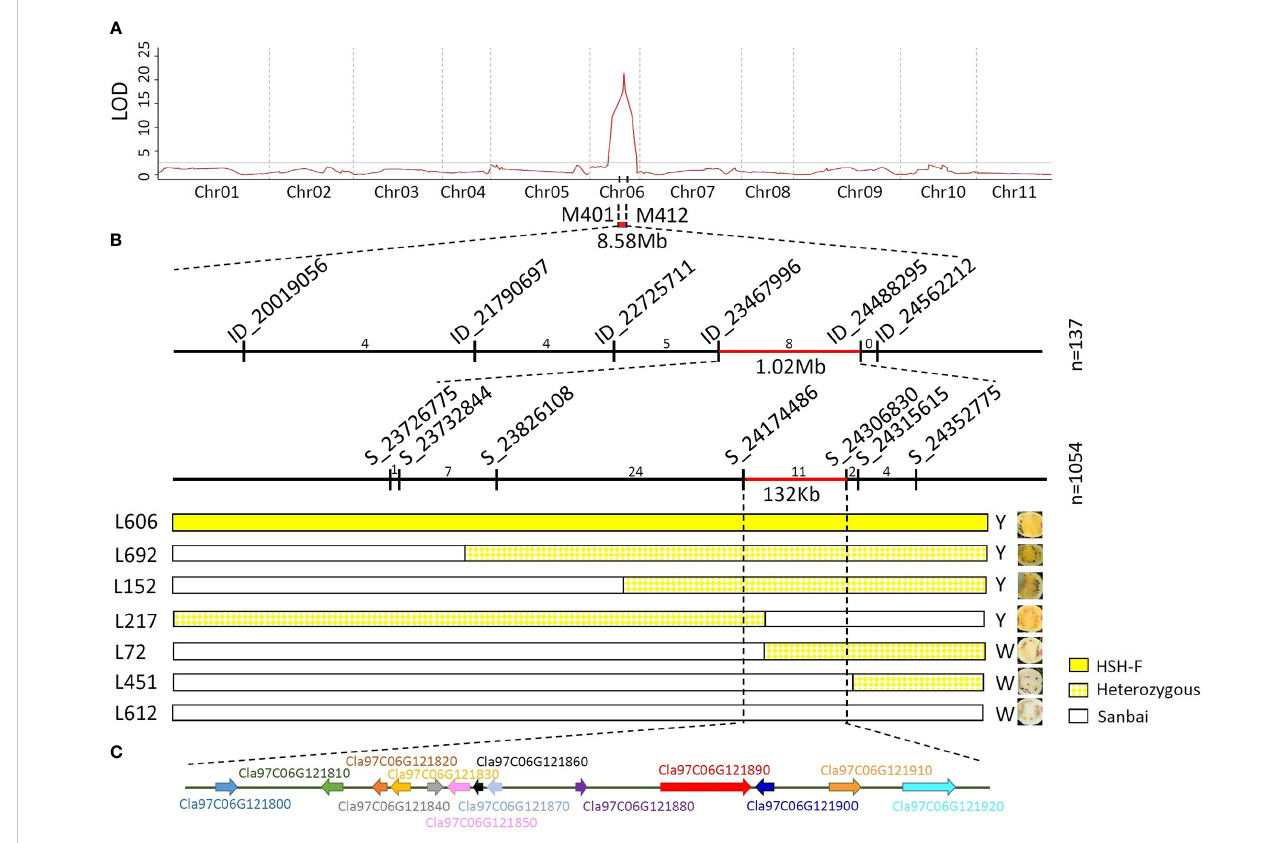
FIGURE 3 Genetic mapping of the Clwf2 locus. (A) Preliminary mapping of the Clwf2 locus. (B) Fine mapping of the Clwf2 locus. (C) Genes in the candidate region for Clwf2 . Numbers above the chromosome represent recombinants between adjacent markers; n is the number of plants used for